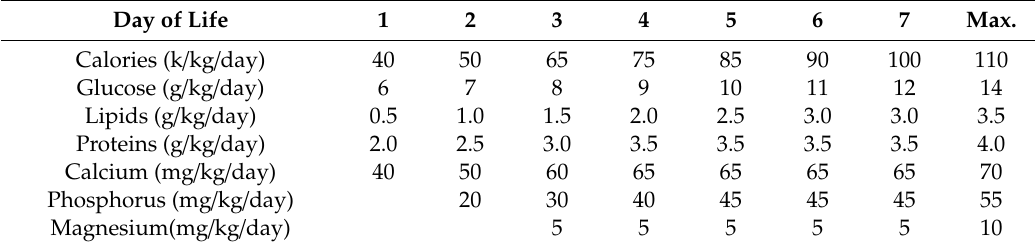
Table A1. The composition of PN through the study